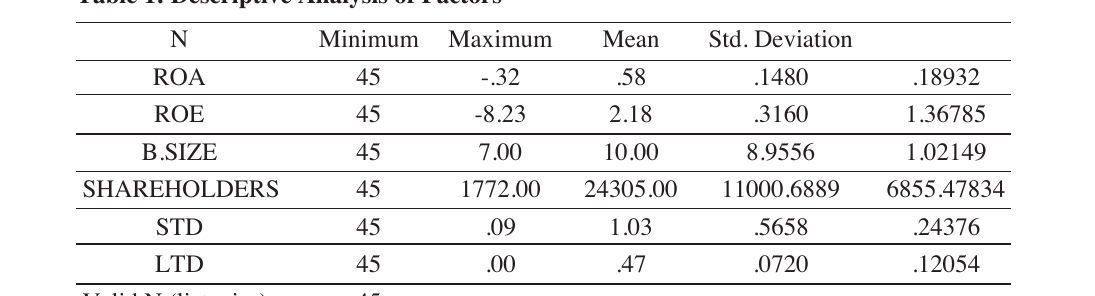
Table 1: Descriptive Analysis of Factors